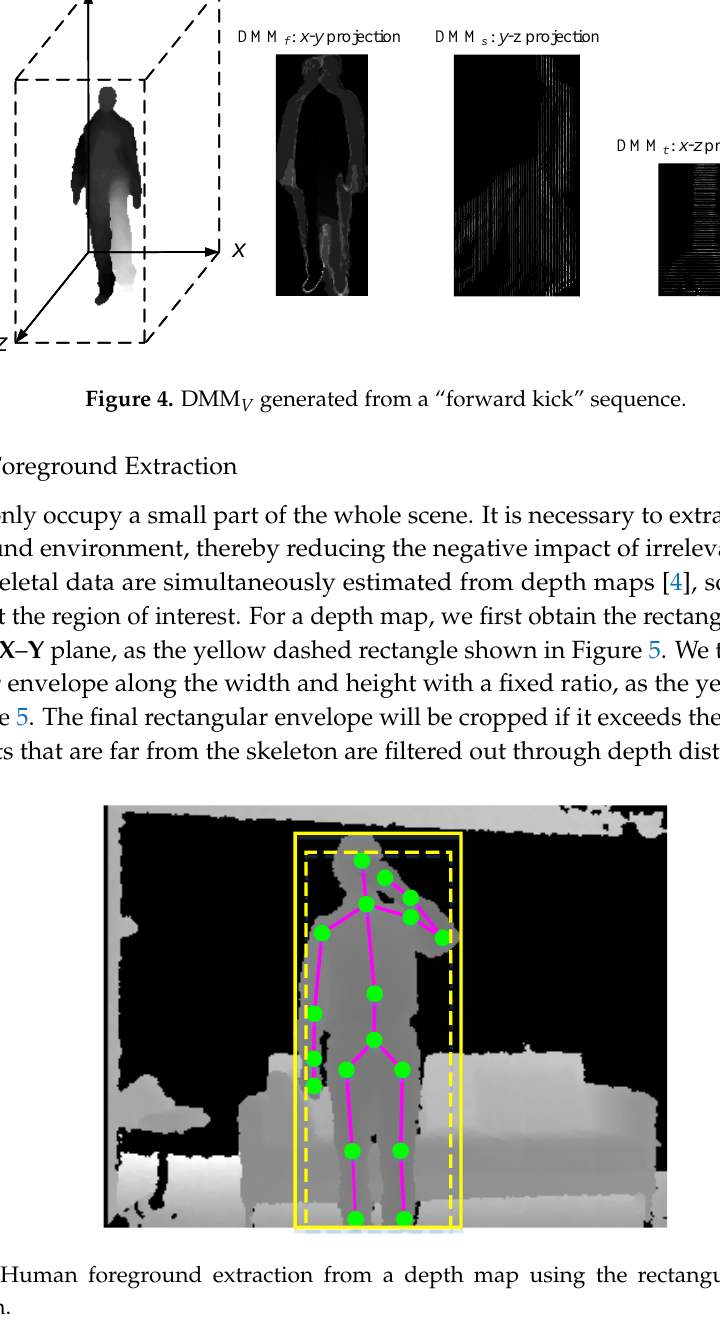
Figure 4. DMM V generated fro m a “ forward kick ” sequence .